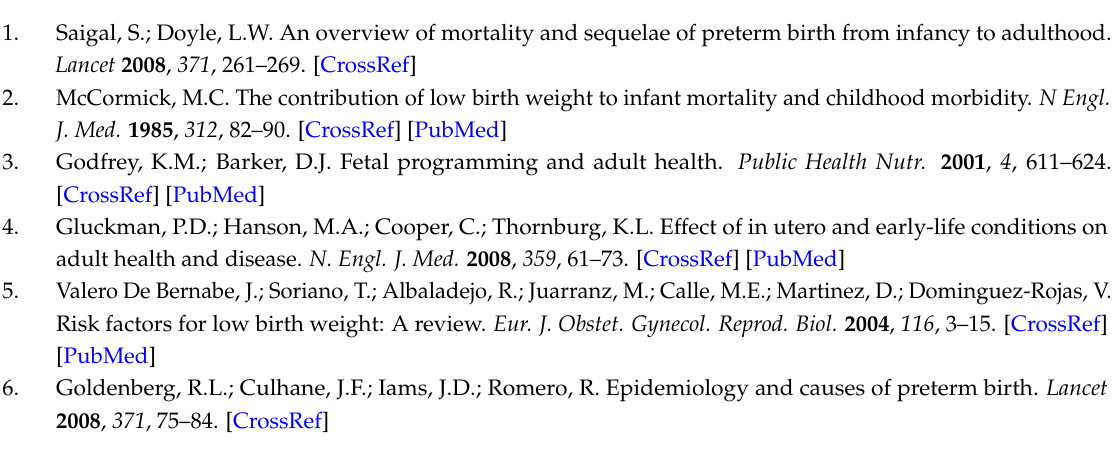
Table S1: Post-disaster food purchasing patterns; Table S2: Regression model for post-disaster preterm birth; Table S3: Number (percentage) of low birthweight and preterm births by food purchasing